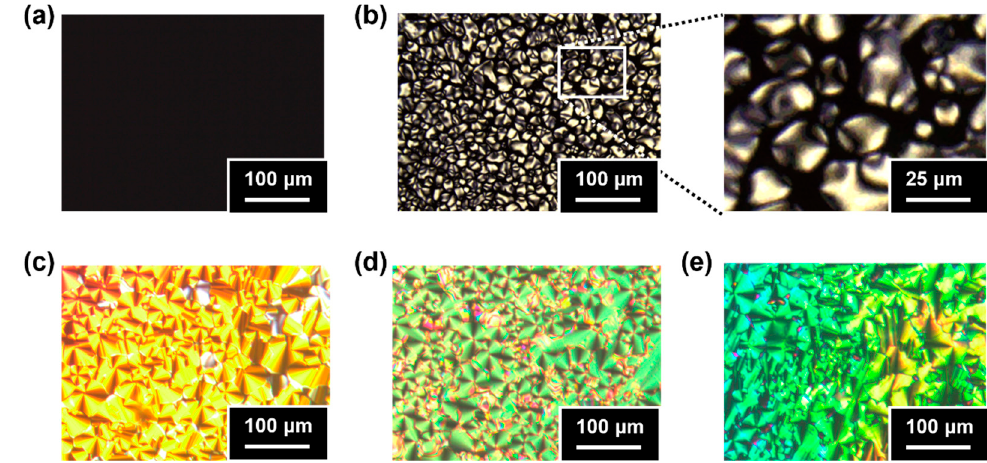
Figure 2. Polarized optical microscopic images of the mixtures of pQpdS-Ch and H 2 O in the 100–X:X weight ratios. ( a ) X = 90 at 25 °C, ( b ) X = 80 at 10 °C, ( c ) X = 70 at 25 °C, ( d ) X = 60 at 25 °C, and ( e ) X = 50 at 25 °C.